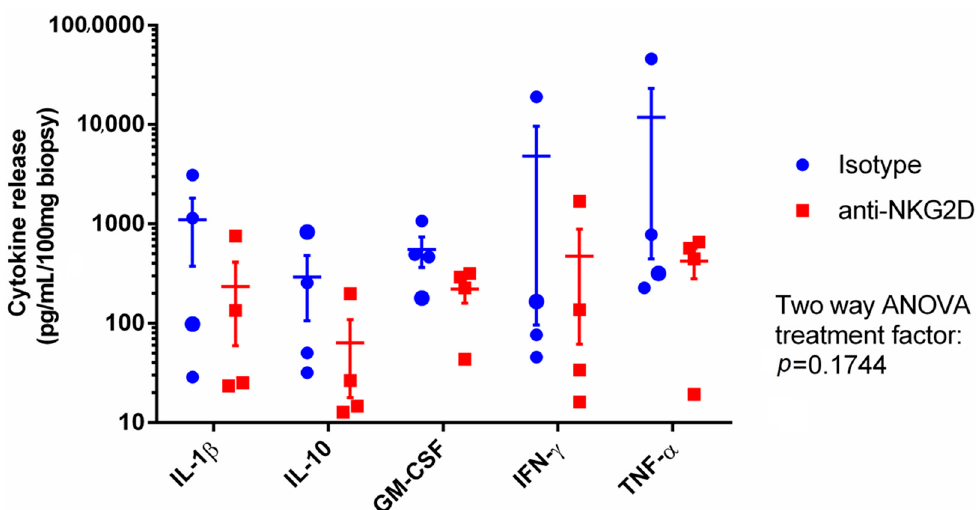
Figure 3. Inflamed intestinal mucosal biopsies from four CD patients treated in an explant assay over 24 h with either isotype control or anti-NKG2D antibody. The release of five cytokines to the medium was analyzed and quantified as pg/mL normalized to 100 mg of tissue. The average of measurements from four biopsies are represented in each data point, shown as the mean ± SEM, with two-way ANOVA.